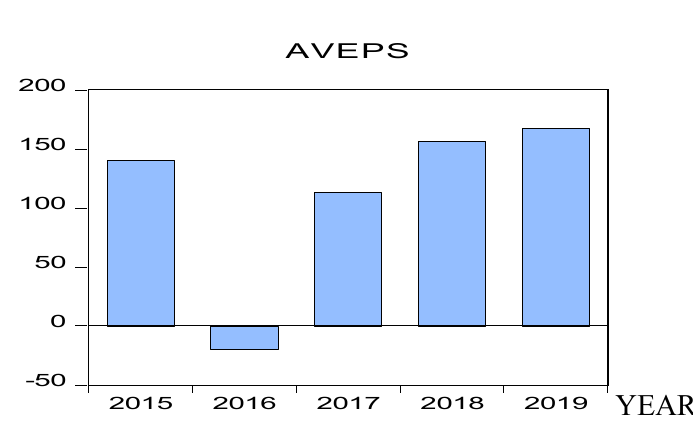
Fig. 4. Trend of earnings per share (Computed by the researchers in E-views 10).